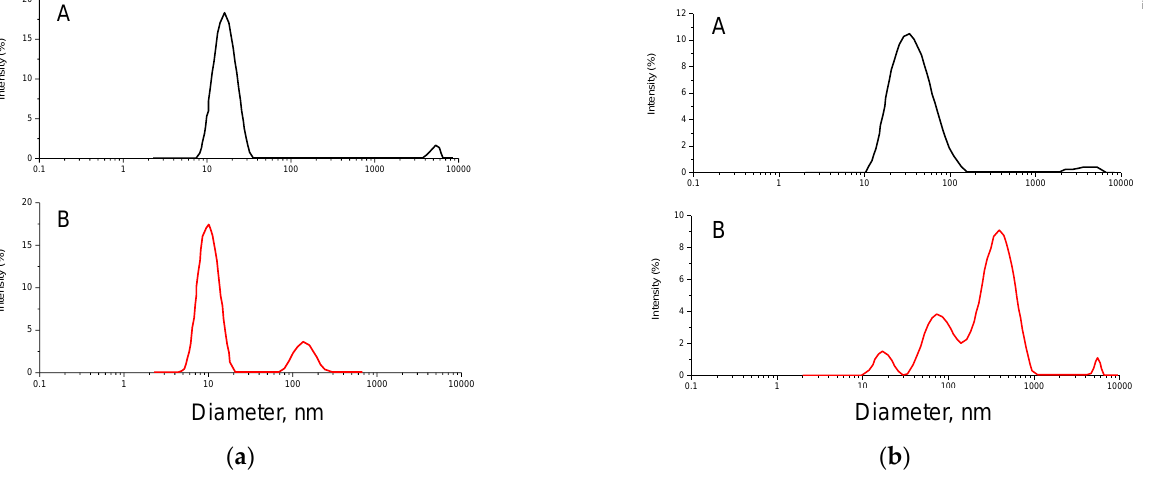
Figure 5. Dynamic light scattering of aqueous solutions before (A) and after addition of PdCl 2 (PhCN) 2 (B): ( a ) (G1) 2 −PEG5k−(G1) 2 micelles; ( b ) (G2) 2 −PEG11k−(G2) 2 micelles. See Sections 2.2.5, 2.3.7 and 2.3.8. in ‘Materials and Methods’ for analysis conditions. It has been shown previously that triazole rings attached to bis-MPA dendritic branching are able to efficiently bind Pd salts [24]. A simple experiment was used to test the binding ability of the newly synthesized materials by adding bis(benzonitrile)palla- dium(II) chloride to water with and without the novel linear-dendritic block copolymers, Figure 6. In pure water, the Pd salt precipitated (orange solid on the bottom of the vial, Figure 6a), while the copolymer solution became clear after vortex stirring for 30 s, Figure 6b. The complexation of the palladium(II) chloride was manifested by distinct chemical shifts in the 1 H NMR spectra, Figure 1D. The positions of the protons in the poly(benzyl ether) dendrons remained unchanged, but the protons associated with the bis-PPA moiety and triazole rings shifted, Figure 1C,D. The DLS scans of the linear dendritic copolymer micelles with molecularly bound PdCl 2 differed from the pure linear-dendritic micelles, Figure 5, B. The Pd-containing (G1) 2 -PEG5k-(G1) 2 micelles existed as two species, one with a diameter of 10 nm and one with a diameter of 120 nm (Figure 5a, B). The (G2) 2 -PEG11k-